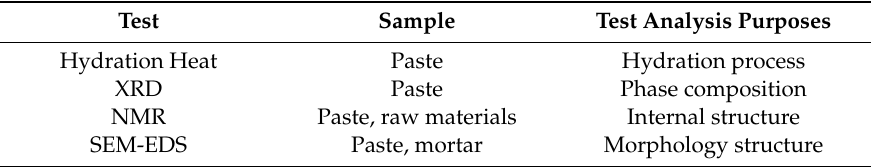
Table 7. Content of the test and